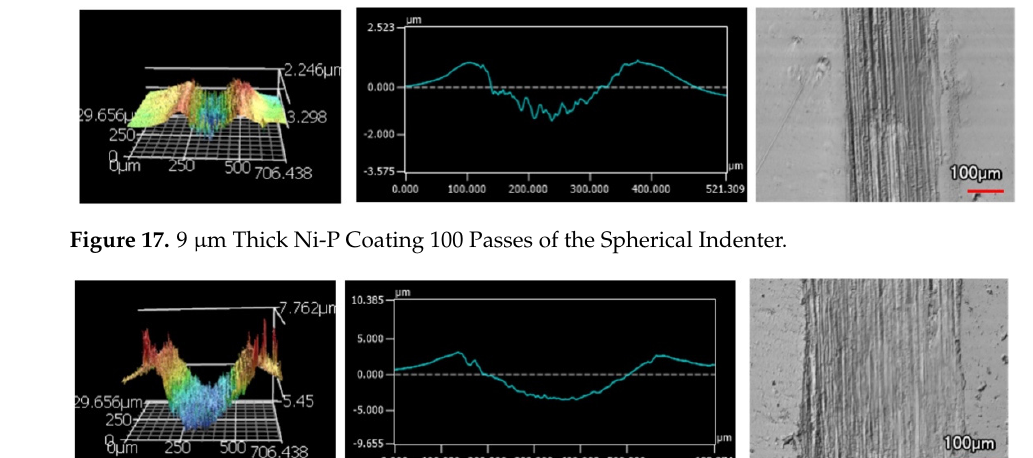
Figure 16. 45 μ m Thick Ni-P Coating 100 Passes of the Spherical Indenter.